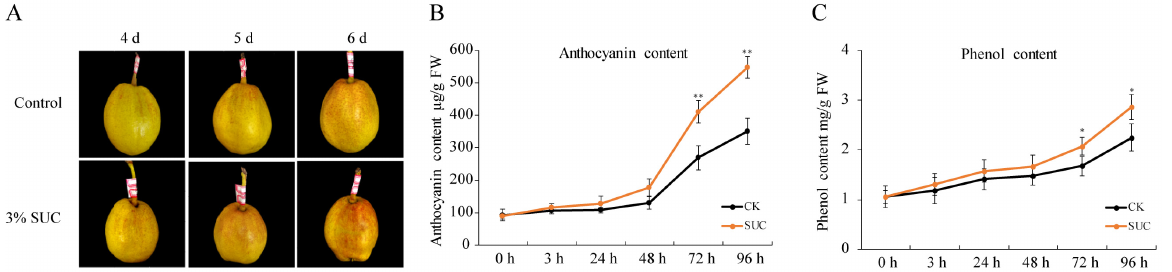
Figure 1. Application of exogenous sucrose promoted anthocyanin accumulation in ‘Kuerle Xiangli’. ( A ) Phenotypes of ‘Kuerle Xiangli’ under sucrose treatment at different time points. Measurement of the ( B ) anthocyanins and ( C ) phenol content in ‘Kuerle Xiangli’ under sucrose treatment. Asterisks indicate statistical significance (*, p < 0.05; and **, p < 0.01) calculated by Student’s t -test.